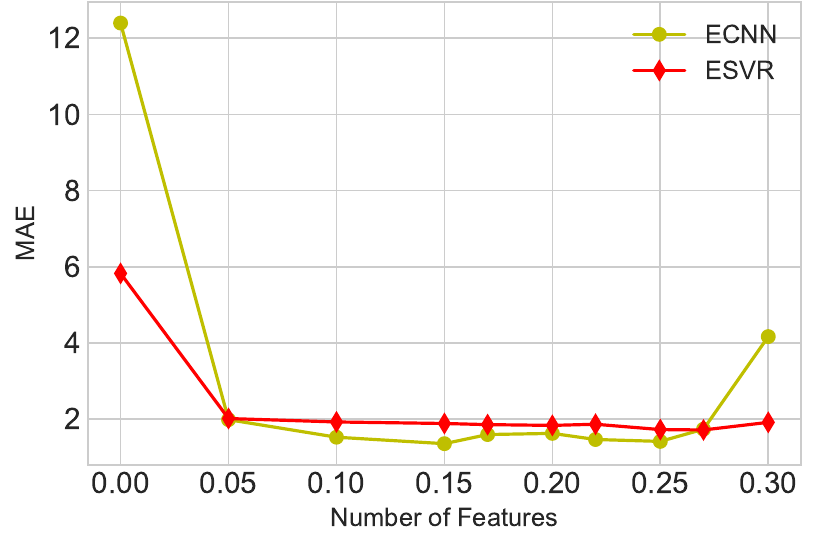
Figure 22. Effect of Hybrid Feature